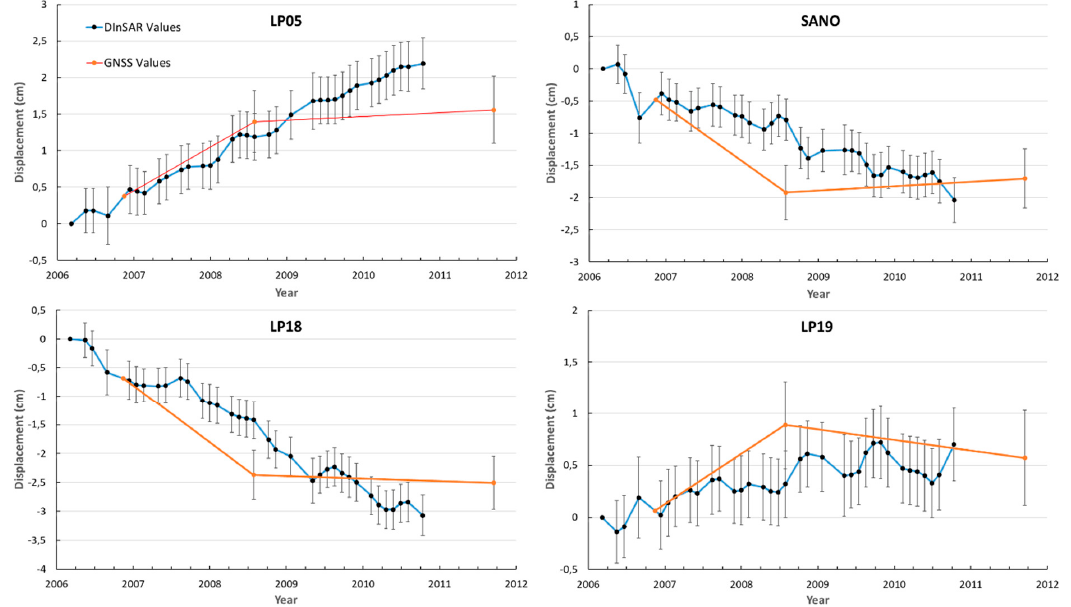
Figure 12. Deformation from InSAR and four stations (LP05, LP17, LP18 and SANO). A-DInSAR time series from descending orbit are plotted along GNSS values projected into the LOS vector to compare both datasets.